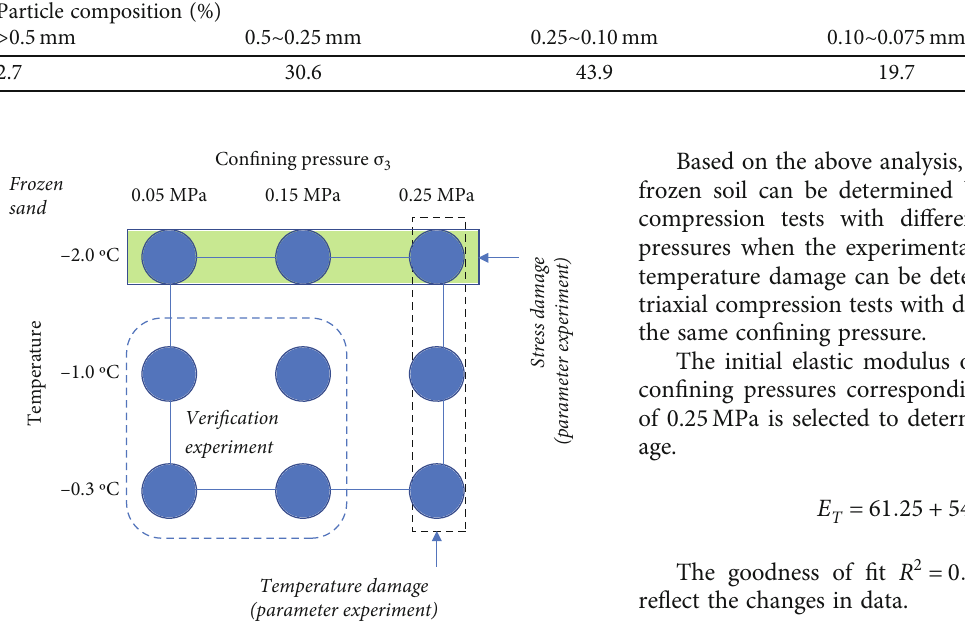
Figure 1: Schematic diagram of the triaxial test conditions of frozen